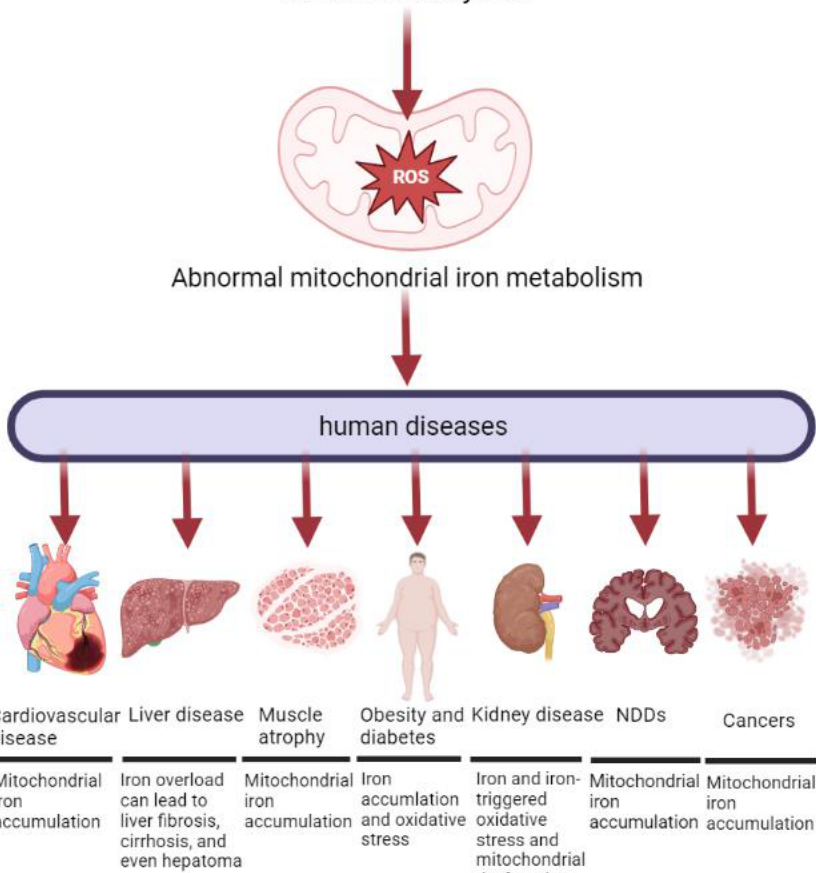
Figure 5. Abnormal mitochondrial iron metabolism can cause different diseases in the human body. Both insufficient and excessive levels of iron can be detrimental to mitochondrial